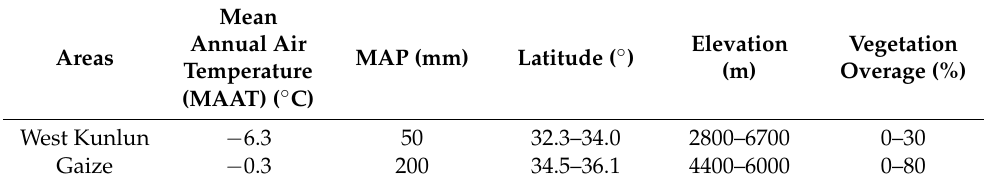
Table 6. Environmental and meteorological factors at the West Kunlun and the Gaize